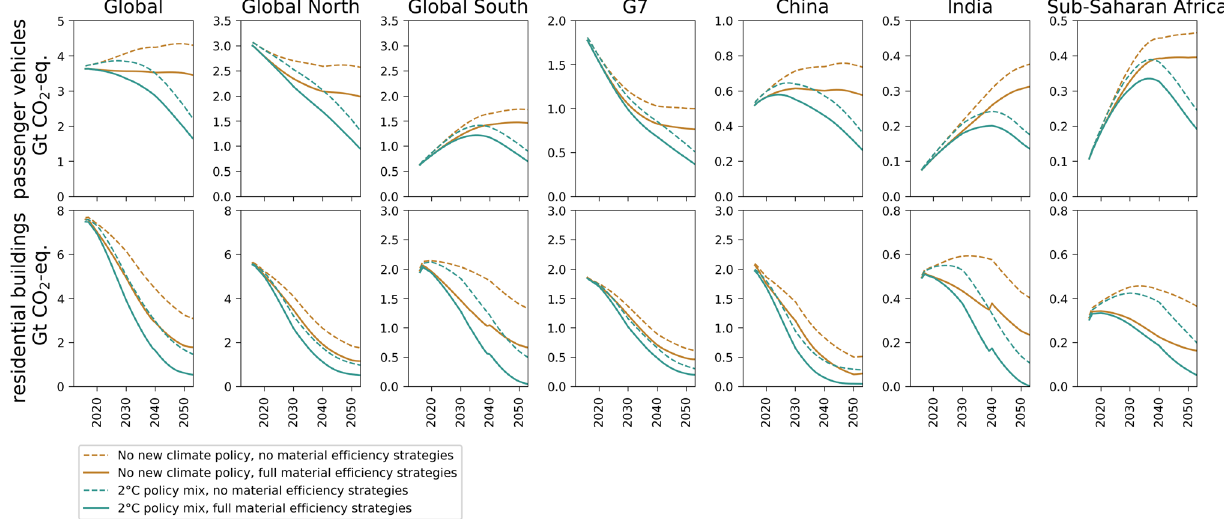
Fig. 2 Greenhouse gas (GHG) emission scenarios (in gigatons (Gt) of CO 2 -eq/yr) by region and time. Results are shown for passenger vehicles (top row) and residential buildings (bottom row) for the SSP1 shared socioeconomic pathway (easy adaptation and mitigation) and two climate policy scenarios, with no material ef fi ciency (ME) strategies considered and the full spectrum of ten strategies considered. See Section 5 of the Supplementary Material for scenario results for the other scenarios and for all 20 model regions. G7 refers to the Group of Seven countries.